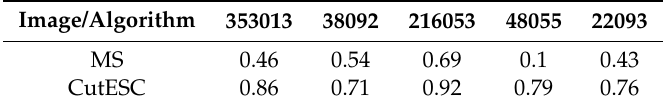
Table 4. ARI values obtained from MS and CutESC clustering algorithm.